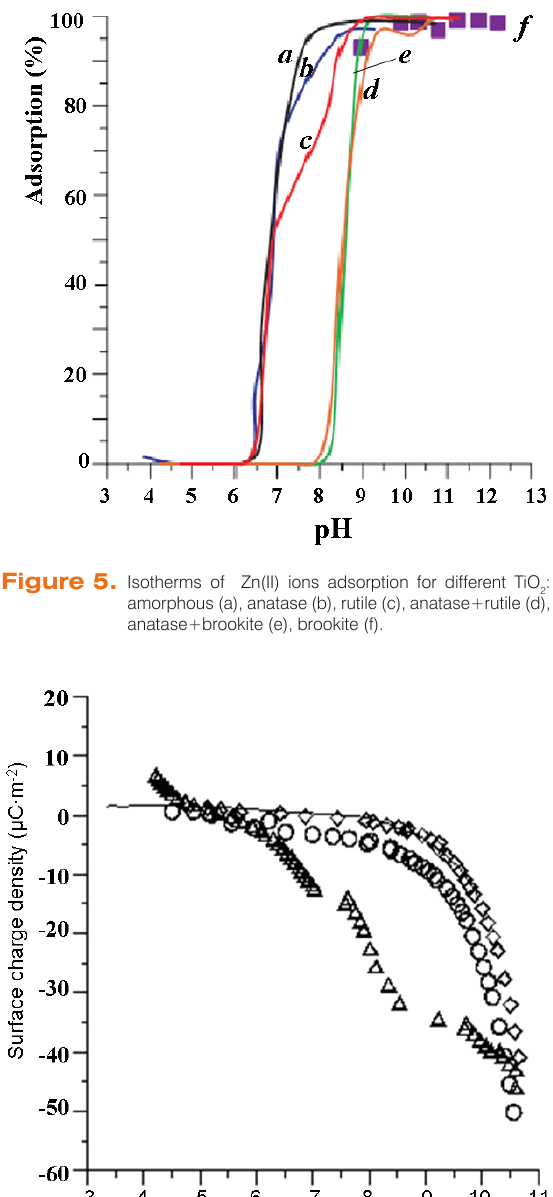
(amorphous) as a 2